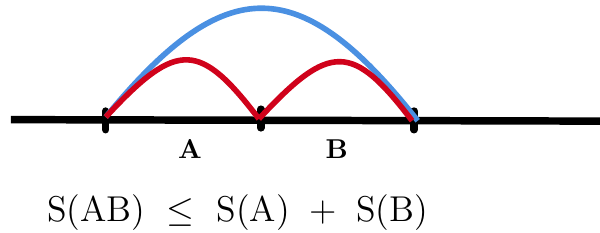
Figure 4 . Cutting and pasting proof of Subadditivity. To form a curve (though not necessarily a minimal one) that separates the region AB from its complement, we can simply take the union of a curve for A and a curve for B , as in the triangle inequality.